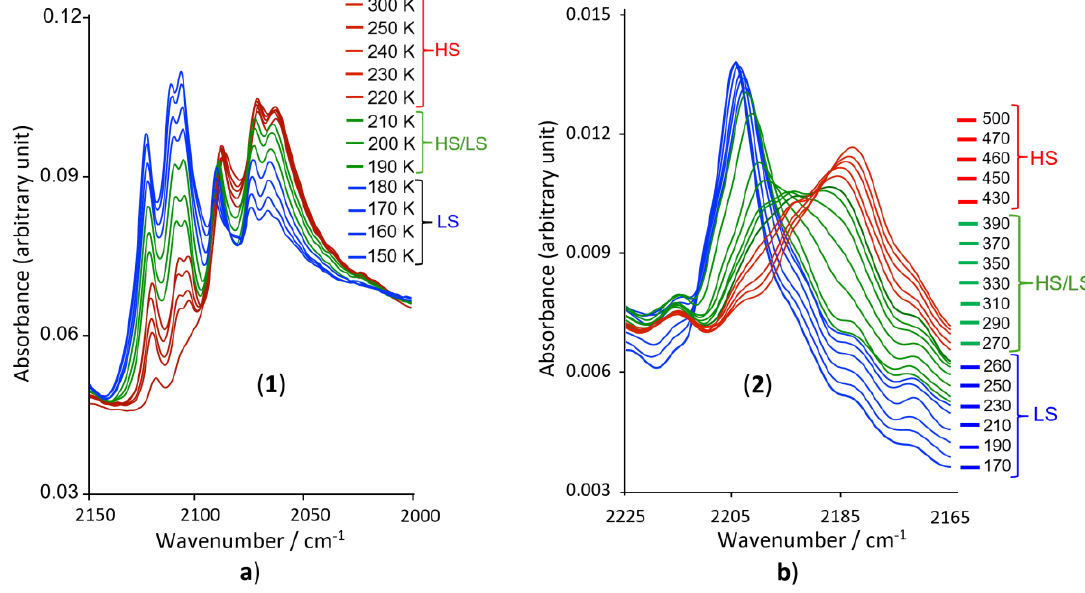
Figure 4. Temperature dependences of the infrared spectra in the temperature region 300–150 K, for compound 1 ( a ) and in the temperature region 500–170 K for 2 ( b ).